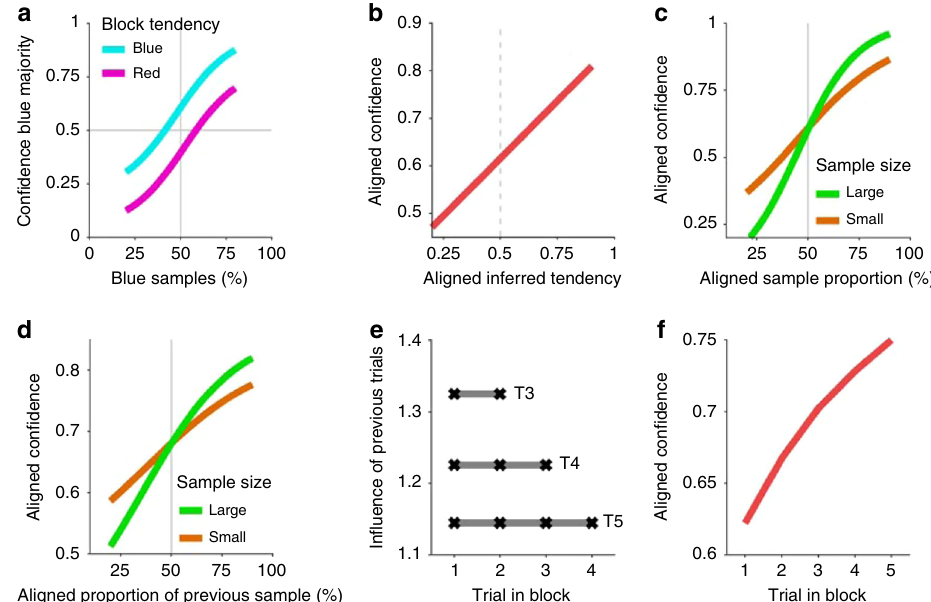
Fig. 4 Characteristic behavioral patterns of probabilistic inference in the hierarchical inference task a Con fi dence in a blue majority of the current airplane (current trial) should increase with the proportion of blue samples, as in the previous task, but in addition con fi dence should be larger in a block that favors blue majorities (cyan) than in a block favoring red majorities (magenta). b Information of the block tendency should gradually increase the con fi dence in the corresponding trial majority. Thus, responses can be pooled with respect to the real block tendency. We refer to it as ‘ aligned con fi dence ’ and use the same concept for other relative quantities below. c Con fi dence in the aligned airplane majority increases with the aligned sample proportion. This modulation is stronger for larger sample sizes (green) compared to smaller ones (orange) while it has no effect for an indifferent sample (50% sample proportion, crossing point between the two lines). d Likewise, aligned con fi dence increases with the aligned sample proportion of the preceding trial and is modulated by its respective sample size. e The in fl uence of all previous trials, determined by the weights of a regression analysis, should be equal on average (e.g., trials 1 – 2 on trial 3, T3). However, it decreases with the number of previous trials due to normalization. f Aligned con fi dence increases across trials within a block because evidence for the block tendency accumulates across trials in the block. All patterns are derived from the ideal observer model (see Methods).